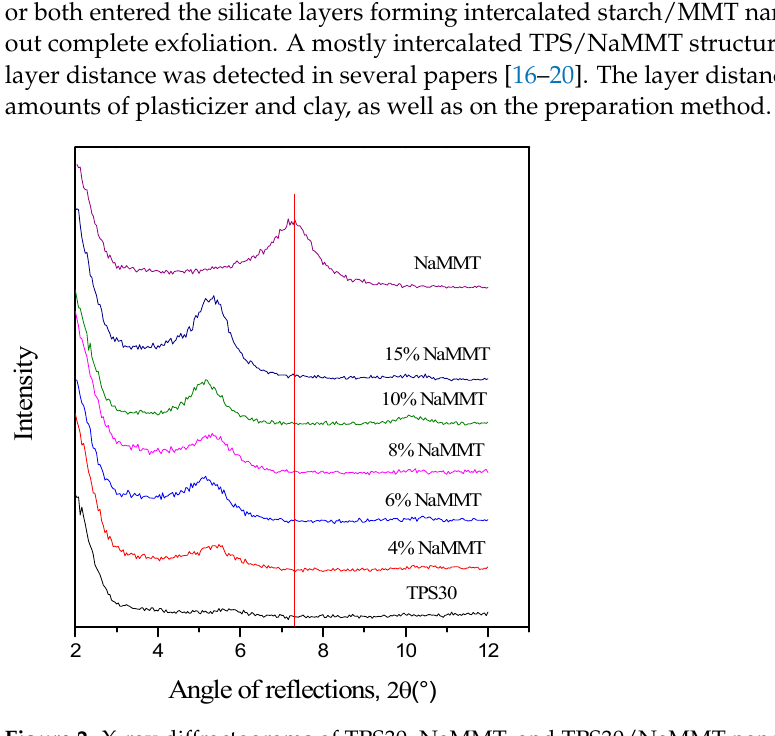
Figure 2. X-ray diffractograms of TPS30, NaMMT, and TPS30/NaMMT nanocomposites. The red line marks the maximum of the NaMMT diffraction peak indicated in the literature around 7.3°